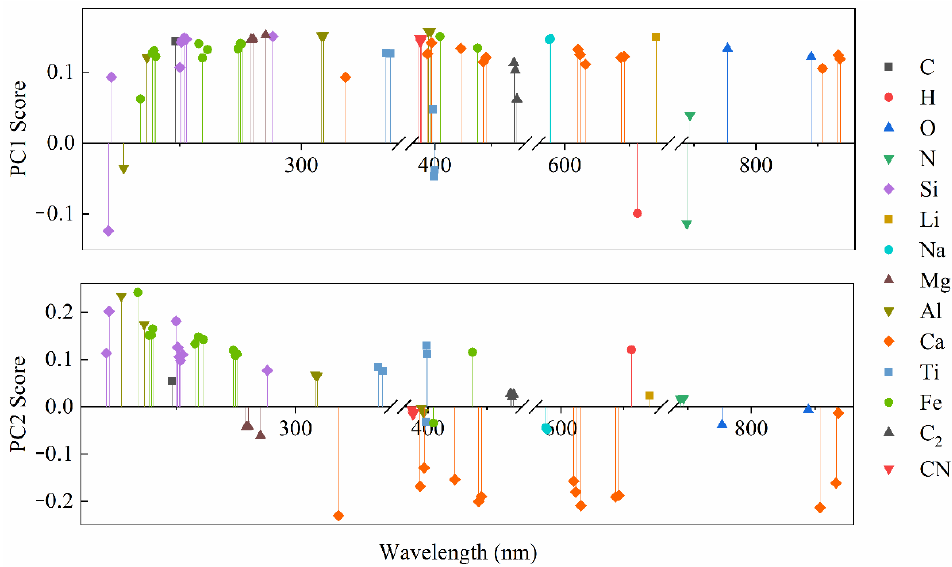
Figure 4. Loading plot of spectral emission lines on the first two principal components.